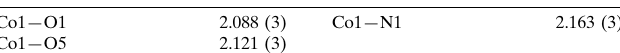
Selected bond lengths (A˚ ).